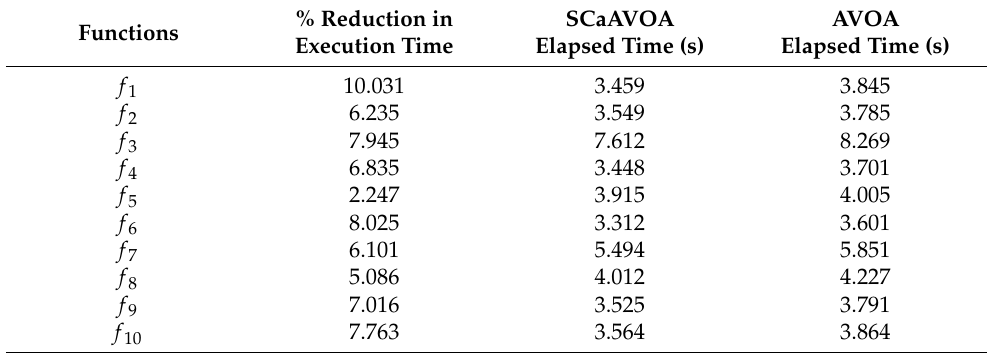
Table 3. Comparison of computational time between the SCaAVOA and AVOA algorithms for the considered standard benchmark functions ( f 1 – f 10 ).